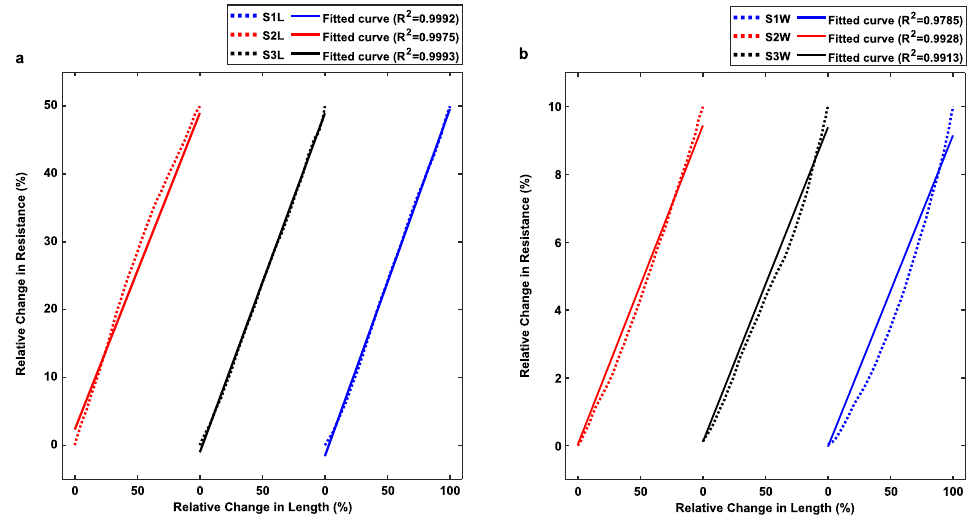
Figure 13. The Characterization diagrams of each of the three sensors for both ( a ) L and ( b ) W compartments. Note : index i in SiW and SiL refers to Type-i sensors for i: 1, 2, and 3.